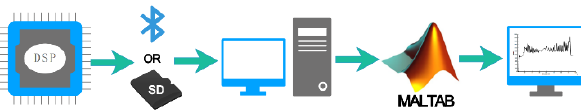
Figure 9. Signal processing and result display flow chart.